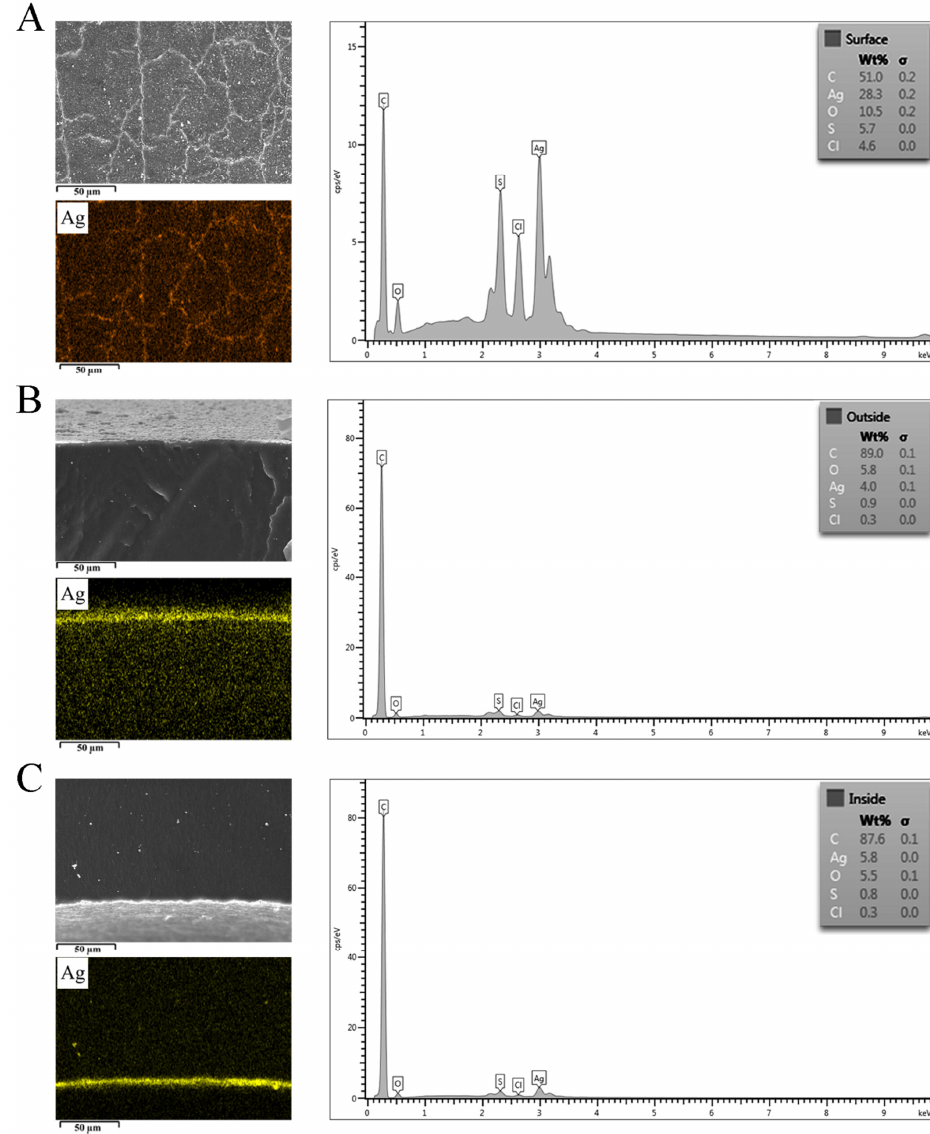
Figure 2. Field emission scanning electron microscope micrographs and energy-dispersive X-ray spectroscopy elemental mapping of ( A ) surface, ( B ) cross-sectional outer and ( C ) inner surfaces of AgNPs-coated urinary catheters.